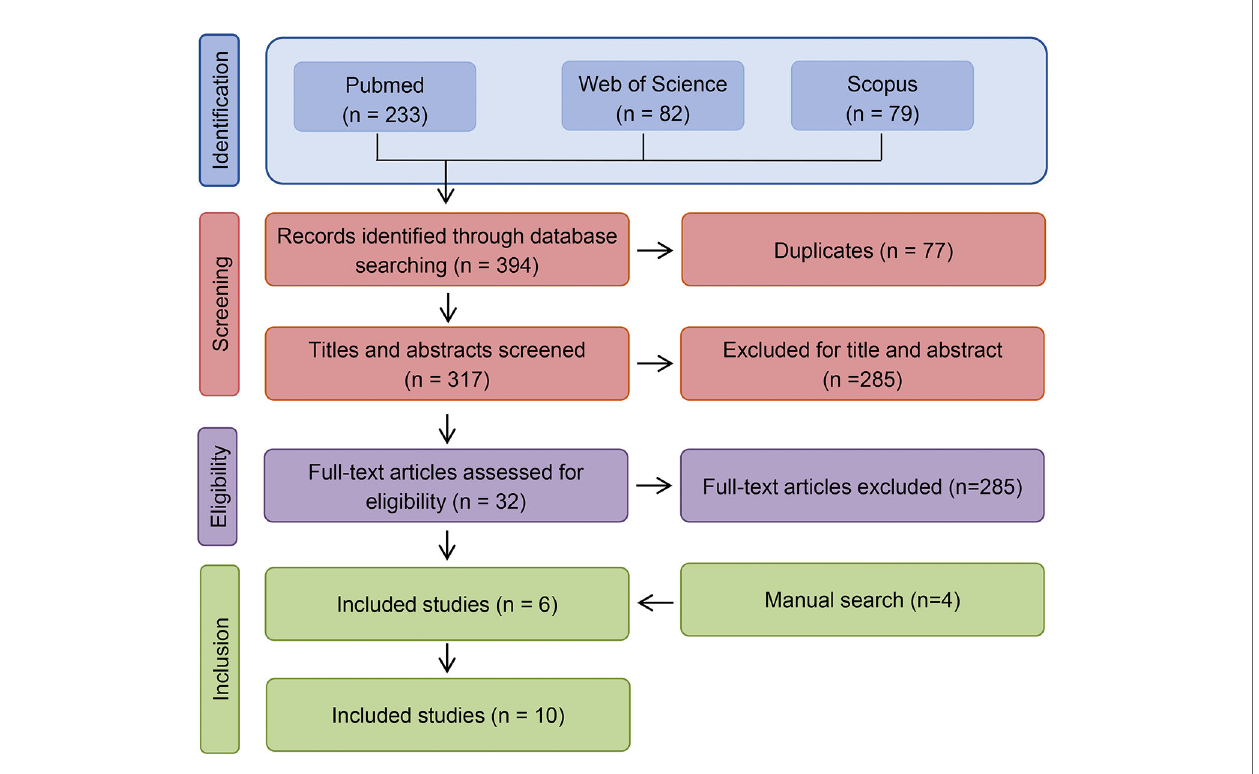
FIGURE 2 | PRISMA fl ow diagram of search strategy and